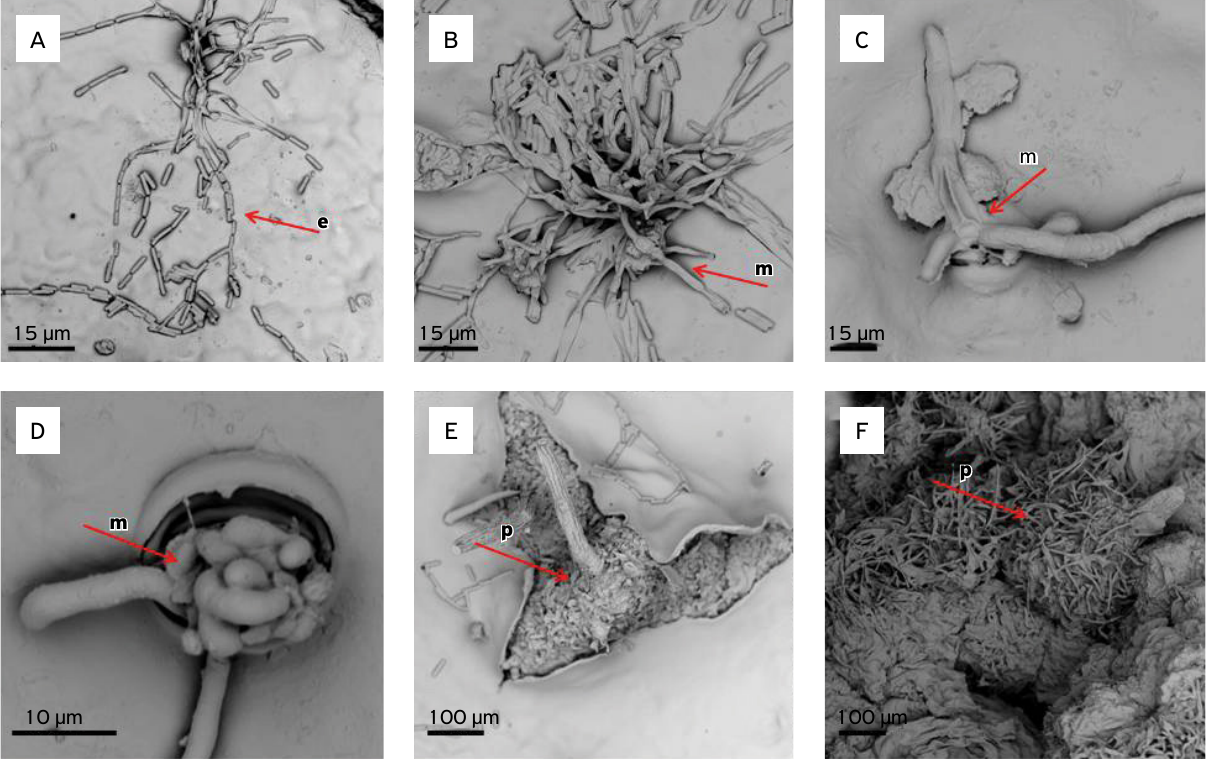
Figure 2. Details of the surface (A, B, C, D and E) and the inner part (F) of the passion fruit at 96 hours post-inoculation of Ceratocystis isolate from passionflower.